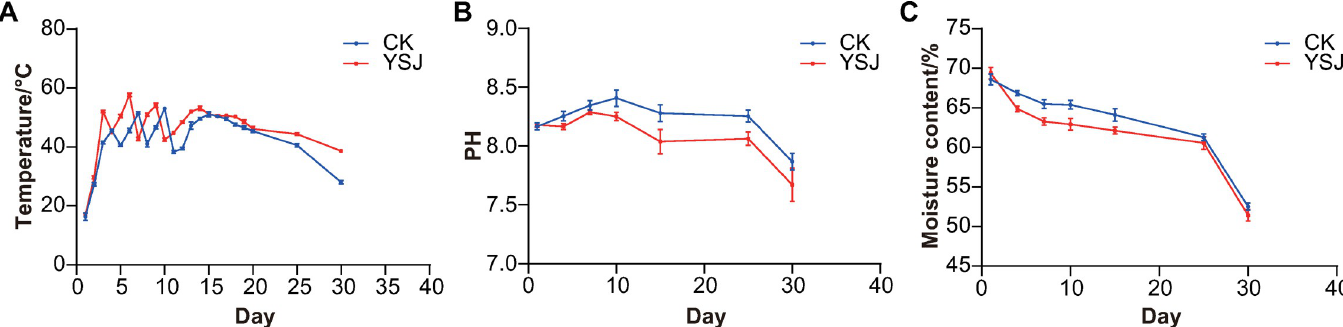
Fig 5. Effects of YSJ inoculation on composting of Yanshan ginger. (A) Changes in temperature during composting. (B) Changes in pH during composting. (C) Changes in moisture content during composting.